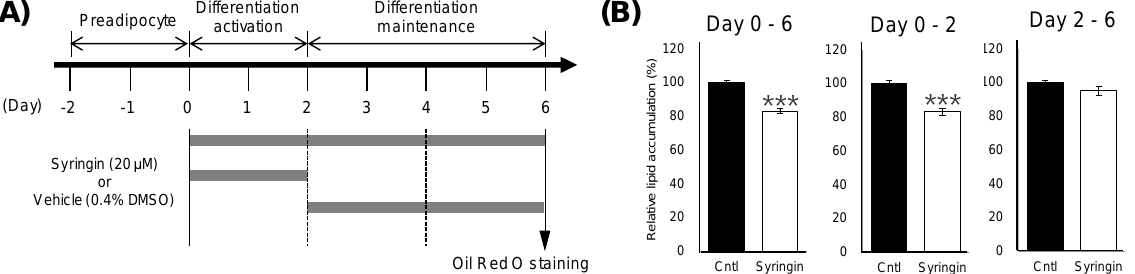
Figure 3. Effect of syringin on intercellular lipid accumulation in 3T3-L1 cells. ( A ) Time course of treatment with syringin during the cellular differentiation of 3T3-L1 adipocytes. ( B ) Inhibitory effects of syringin on lipid accumulation in 3T3-L1 adipocytes. The results are presented as means ± SEM of three independent experiments ( n = 3). The asterisk (*) indicates a significant difference between control and treatment groups by the Student’s t - test. *** p < 0.001 vs. control (Cntl).